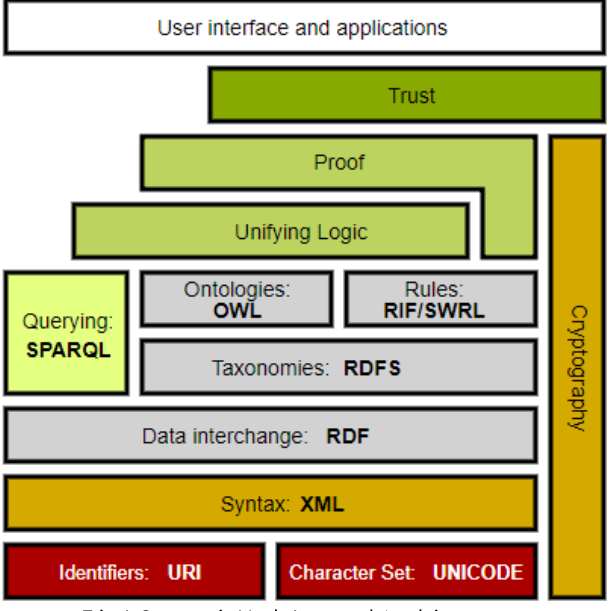
Fig.1 Semantic Web Layered